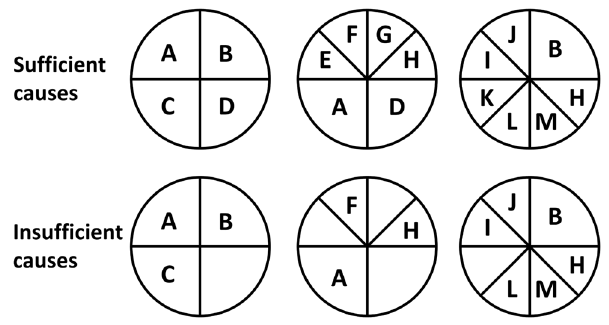
Figure 1. Pie model of sufficient causes for complex disease. Complex diseases may be multiple disorders with similar phenotypic manifestations, or a disorder with multiple genetic causes (subclasses). Each of the subclasses may be a result of combinations of similar, or unique, predisposing genes.